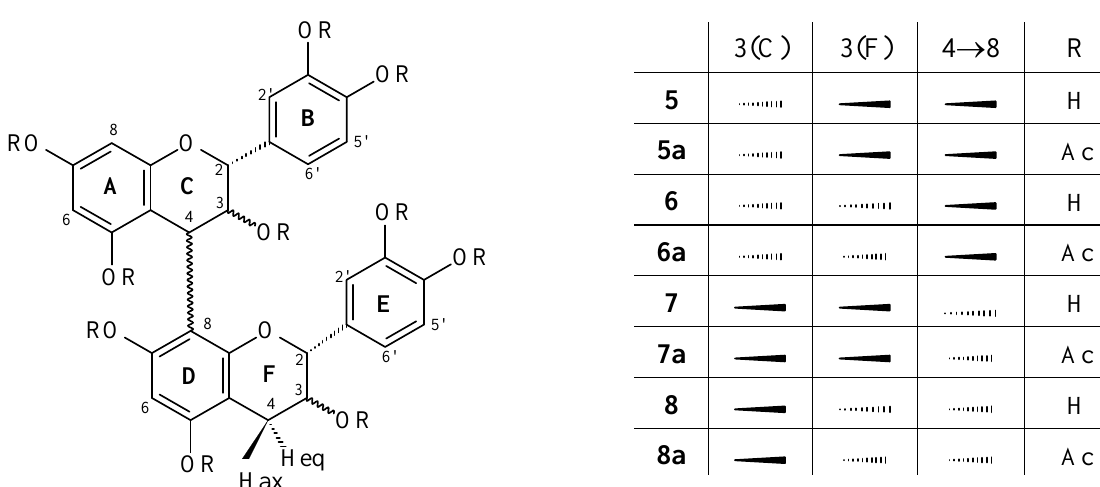
Figure 2. Dimeric procyanidins isolated from Paullinia cupana . Procyanidins B ( 6 ), B ( 7 ), and B ( 8 3 4